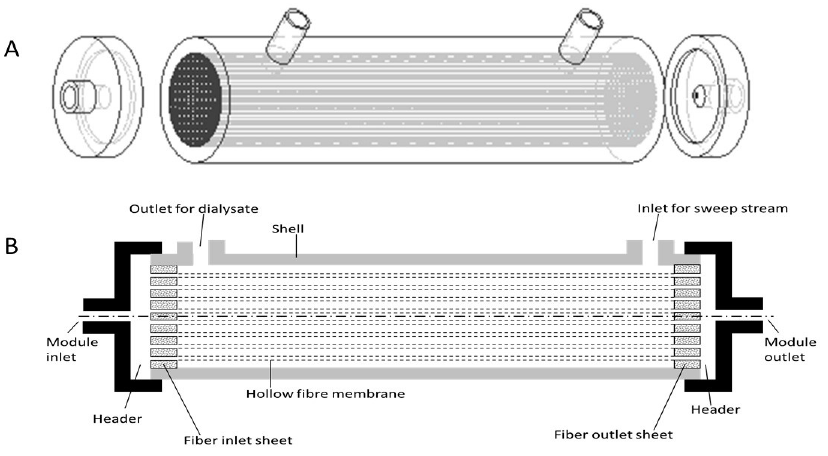
Figure 1. ( A ). Schematic drawing of a conventional hollow fiber membrane based hemodialyzer. ( B ) Section drawing of a conventional hollow fiber membrane based hemodialyzer.